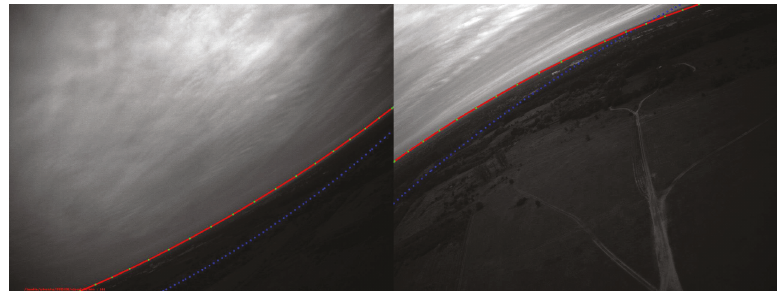
Figure 11: Horizon detection in the image with radial distortion. The blue line represents the horizon calculated from orientation, and the red line corresponds to the improved sky-ground separation.